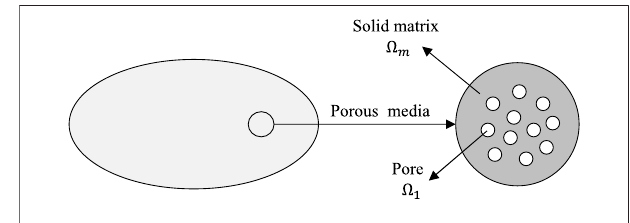
FIGURE 1 | REV physical model of porous